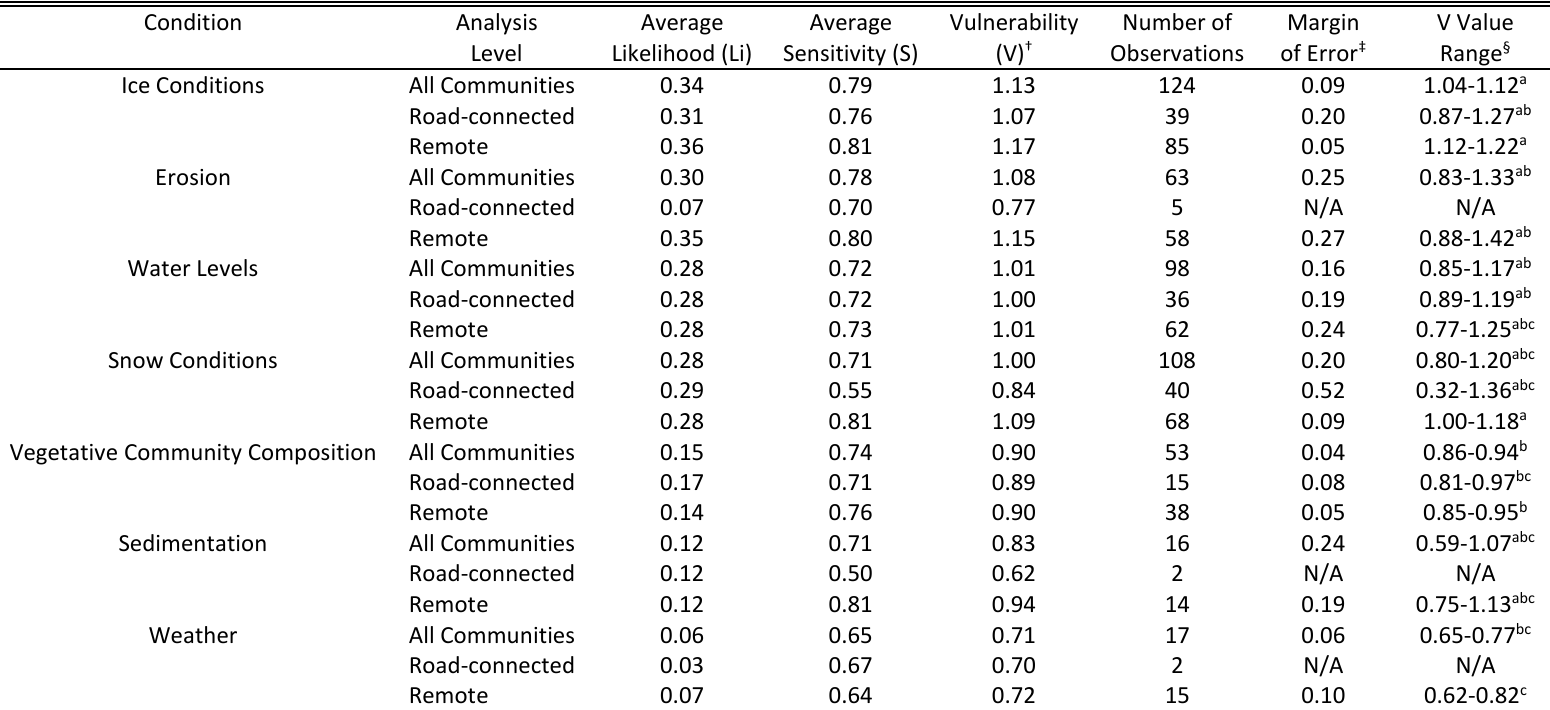
Table A3.1 . Mean values for vulnerability analysis of GPS data among 9 communities, 3 road-connected communities and 6 remote